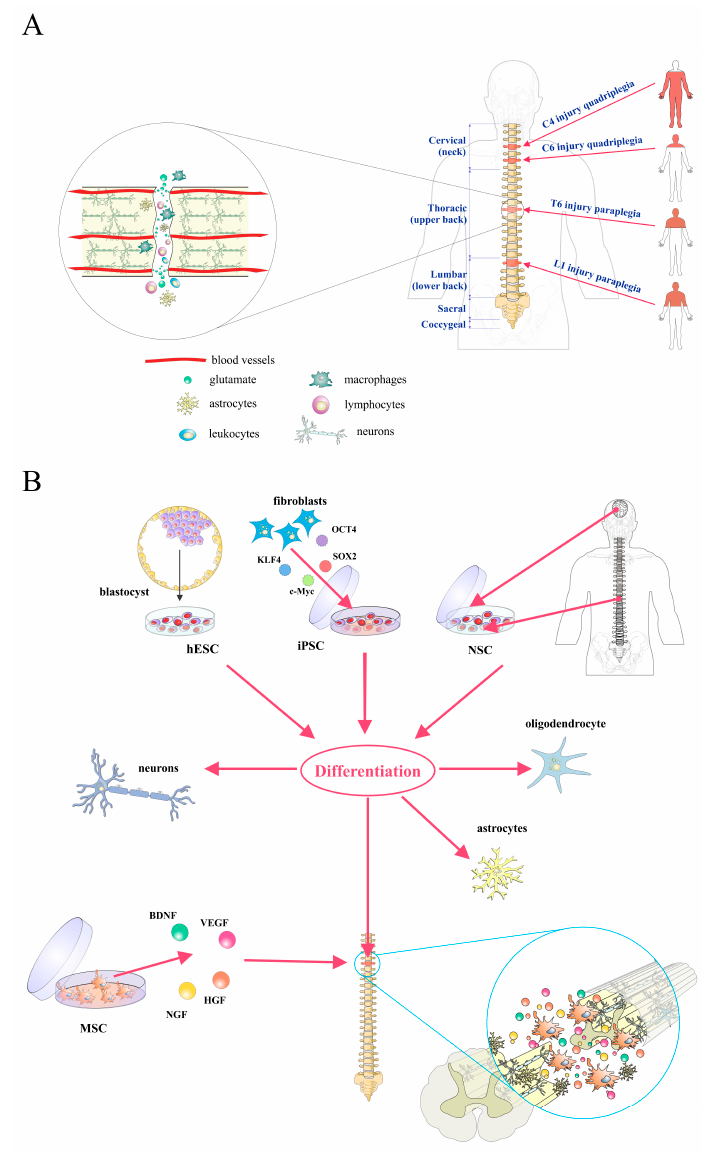
Figure 1. Overview of pathophysiological events and possible stem cells (SCs) treatment for spinal cord injury (SCI). ( A ) The mechanismsand clinical signs of SCI; ( B ) Potential uses of SCs as a source of neurons, oligodendrocytes, and astrocytes, as well as neuroprotectors in SCI. hESCs, human embryonic stem cells; iPSCs, induced pluripotent stem cells; NSCs, neural stem cells; MSCs, mesenchymal stem cells; BDNF, brain-derived neurotrophic factor; VEGF, vascular endothelial growth factor; NGF, nerve growth factor; HGF, hepatocyte growth factor; OCT4, octamer-binding transcription factor 4; KLF4, Kruppel-like factor 4; SOX2, sex determining region Y-box 2; c-Myc, myelocytomatosis oncogene.